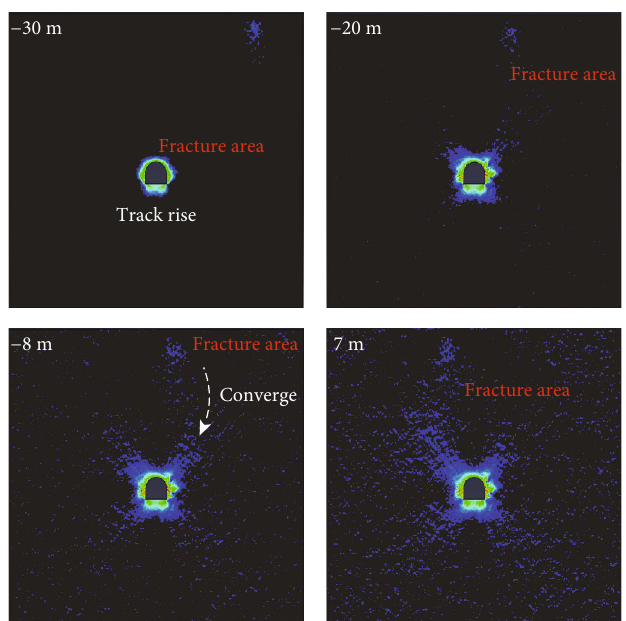
Figure 7: Variation pattern of fracture zone with the advance of working